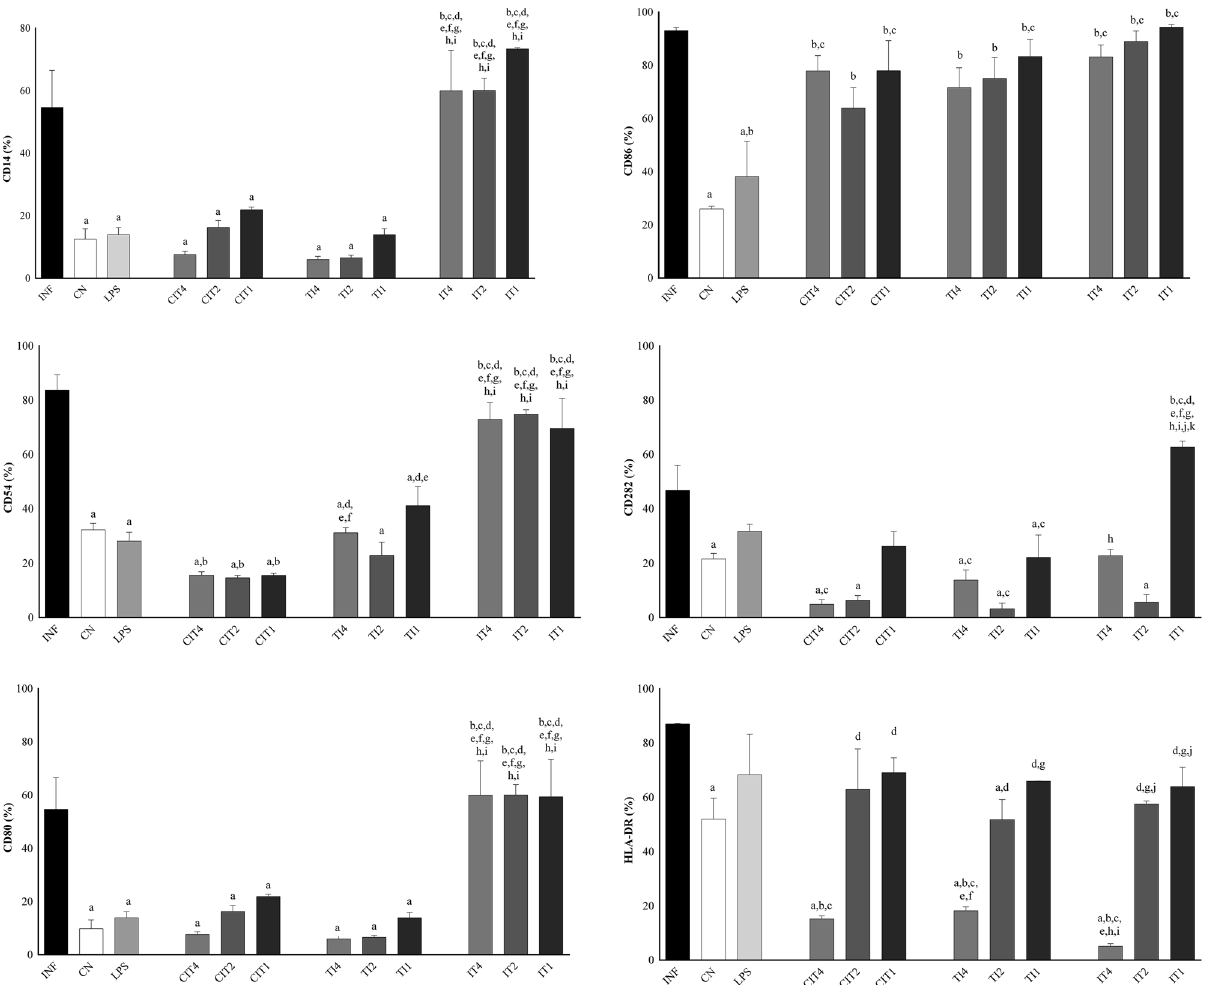
Figure 1. Immunophenotyping of cell surface molecules in monocytes (isolated from males) were performed by flow cytometry. Surface markers CD14, CD80, CD86, HLA-DR, CD82, and CD54. For immunophenotyping, monocytes were divided into the following groups: infected with isolate 80 (INF), negative control group (CN), groups with citral treatment (CIT) at 4%, 2%, and 1% (CIT4, CIT2, and CIT1), groups treated with citral at 4%, 2%, and 1% and infected (TI4, TI2, and TI1), and infected and treated groups with citral at 4%, 2%, and 1% (IT4, IT2, and IT1). Treatment for 30 min and infection for 6 h. Statistically significant differences ( P < 0.05) compared to the INF control are indicated by letters: ( a ) compared to the negative control: ( b ) compared to LPS: ( c ) compared to CIT4: ( d ) compared to CIT2: ( e ) compared to CIT1: ( f ) compared to TI4: ( g ) compared to TI2: ( h ) compared to TI1: ( i ) compared to IT4: ( j ) compared to IT2: ( k ) Statistical significance (one-way ANOVA, with multiple comparisons followed by Tukey’s test; GraphPad Prism